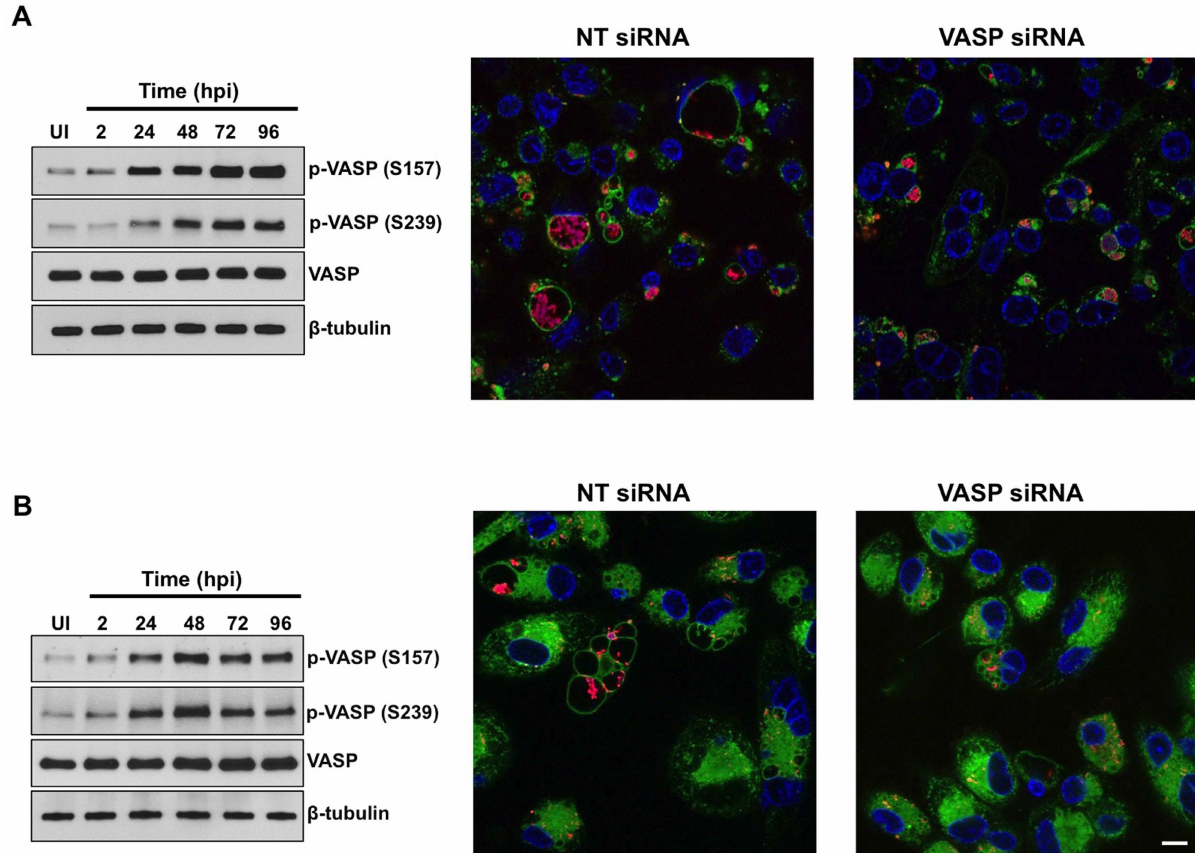
Fig 6. VASP activity is required for virulent C . burnetii PV formation. THP-1 cells (A) or primary hAMs (B) were infected with virulent C . burnetii and lysates collected at the indicatedtimes. Immunoblotting was performed using antibodiesdirected against phosphorylated (S157 and S239) or total VASP (left panels). β -tubulin was used as a loadingcontrol. UI = Uninfected cells. Virulent C . burnetii triggered increasedlevels of phosphorylated VASP from 24–96 hpi in THP-1 cells and hAMs. In the middle and right panels, THP-1 cells (A) or hAMs (B) were transfected with non-targeting (NT) or VASP-specific siRNA. Cells were processedfor confocal microscopy at 72 hpi. DNA was labeledwith DAPI (blue), and CD63 (green) and C . burnetii (red) were detected with antibodies.Bar, 10 μ m. VASP-depleted macrophages contain smaller PV than NT siRNA-transfected